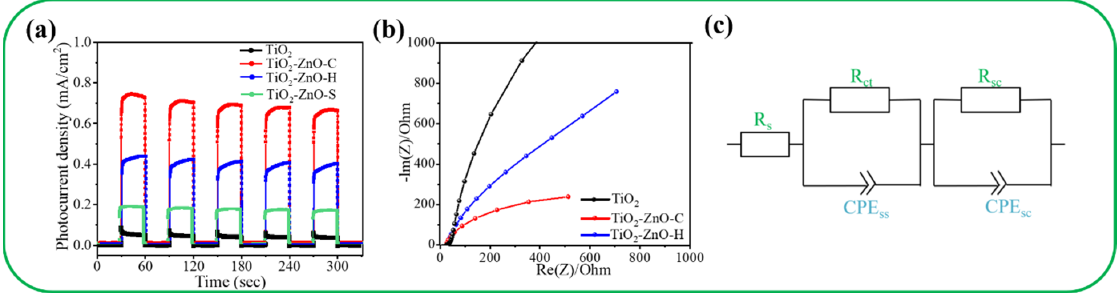
Figure 8. ( a )Transient photocurrent density vs. time curves of various samples under on/off irradiation. ( b ) Nyquist plots of the TiO 2 (black), TiO 2 –ZnO–C (red), and TiO 2 –ZnO–H (blue). ( c ) Possible equivalent circuit model used to evaluate the R ct values of various composites.